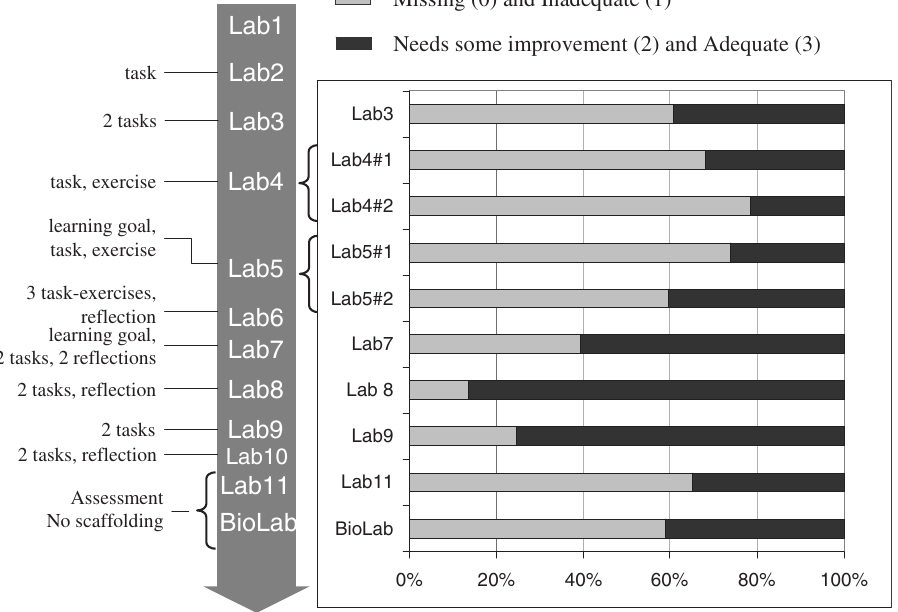
FIG. 5. Ability to evaluate the effects of assumptions. Laborato- ries 4 and 5 had two experiments each, scored separately. The shaded bars represent the percent- age of the students whose labora- tory reports received scores shown at the top of the